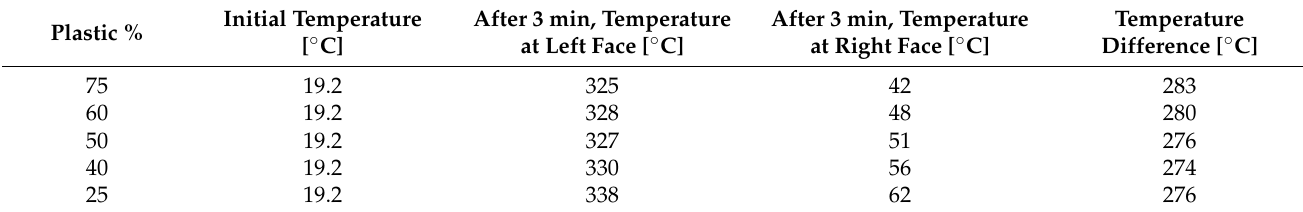
Table 7. Temperature difference of different